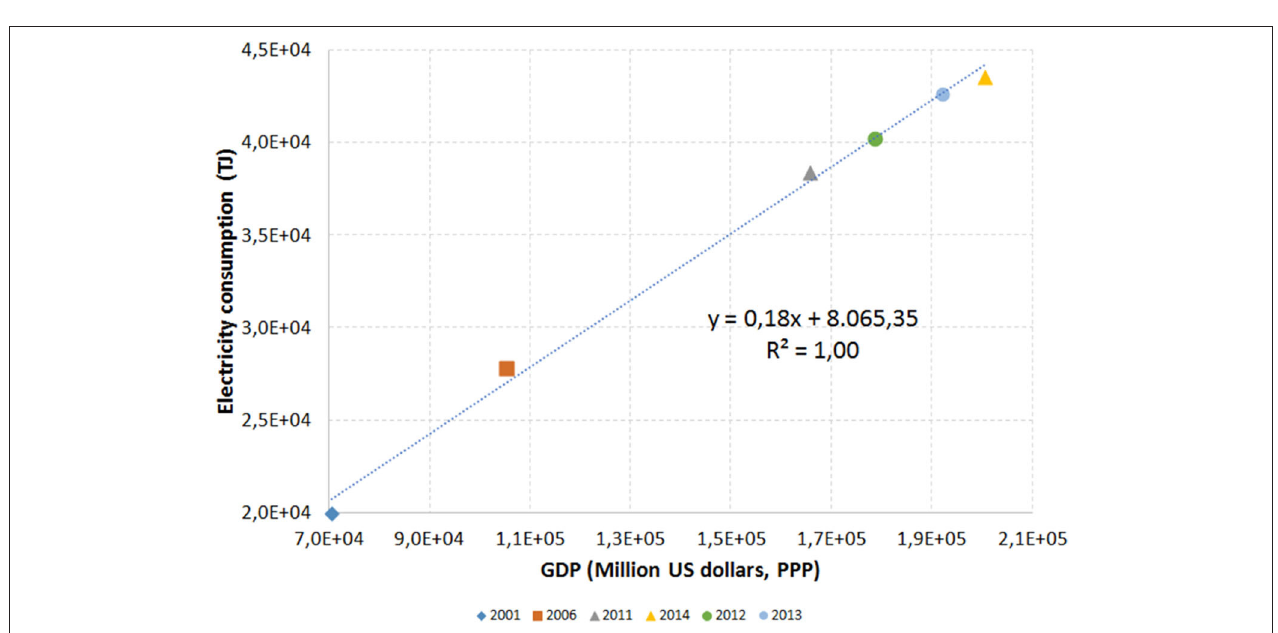
FIGURE 3 | Temporal evolution of electricity consumption vs